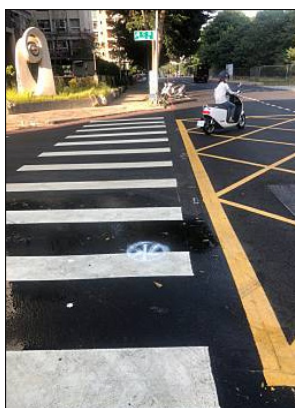
Figure 17. Leak detection personnel of Taiwan Water Corporation sprayed markings within the specified area.